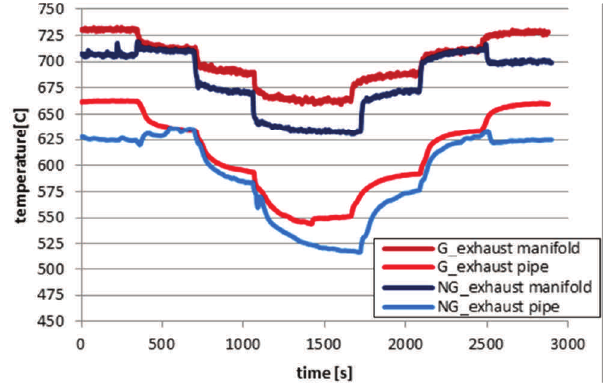
Fig. 3. Exhaust gas temperature in the exhaust manifold and in the pipe behind the catalytic